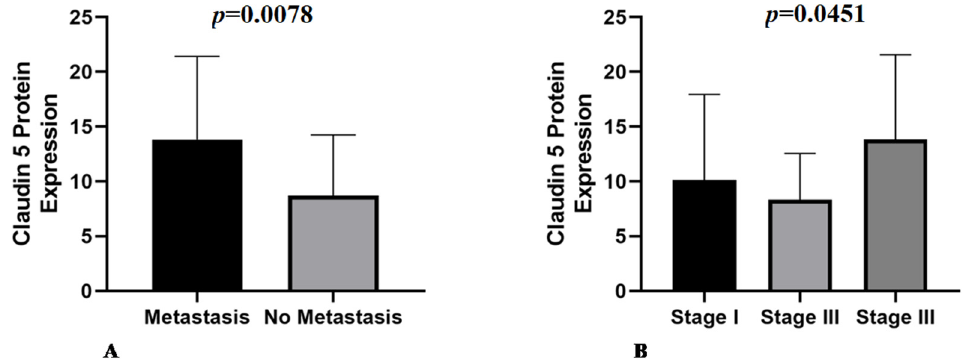
Figure 3. ( A ) Metastatic samples have higher Claudin-5 expression compared with non-metastatic samples ( p = 0.0078). ( B ) Association of Claudin-5 expression with tumor stage, with stage III tumors showing higher expression than stage I and II tumors ( p = 0.0451).